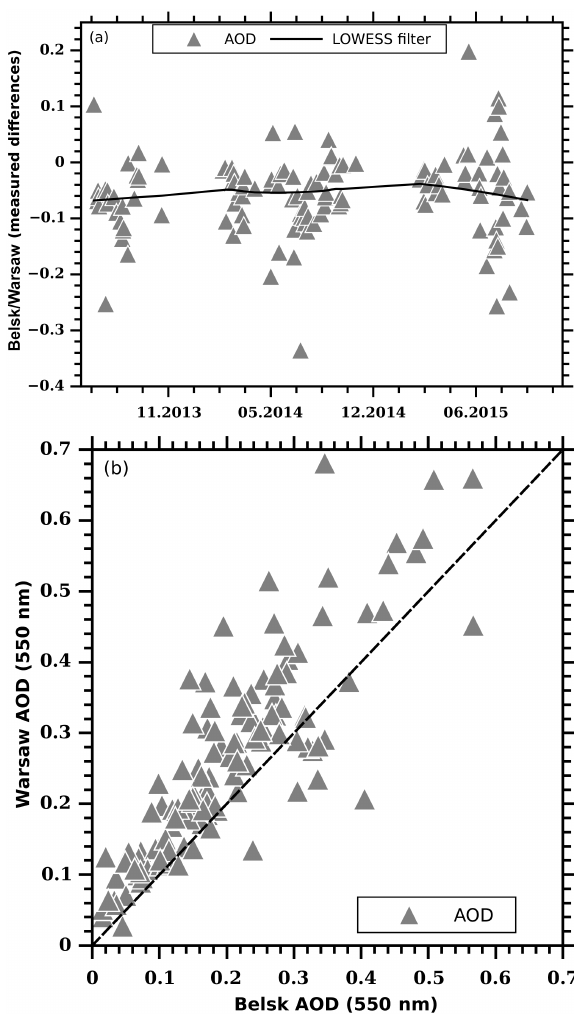
Figure 8. (a) The difference between AOD at 550nm measured simultaneously by MODIS over Belsk and Warsaw in the period May 2013–December 2015. The solid curve represents the data smoothed by the LOWESS filter. (b) Scatter plot of AOD at 550nm measured by MODIS over Belsk and Warsaw from May 2013 to December